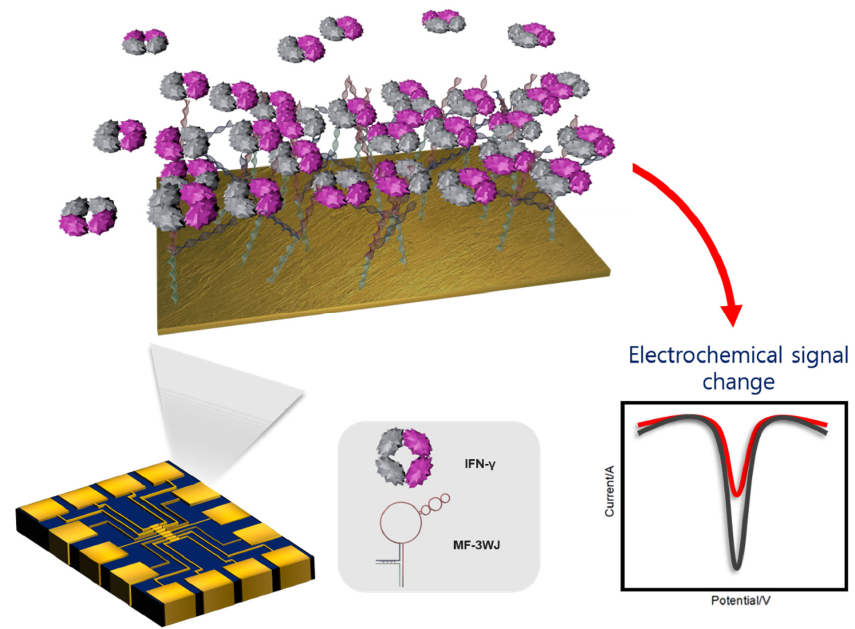
Figure 1. Concept image of the proposed IFN-γ electrochemical biosensor. IFN-γ: interferon gamma, MF-3WJ: multifunctional triple-stranded aptamer, SWV; square wave voltammetry .